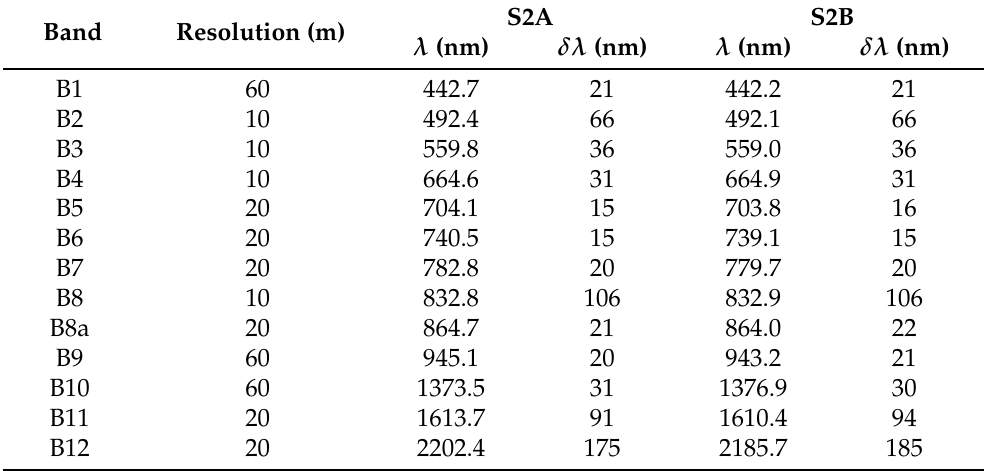
Table 1. Spatial resolution, central wavelength ( λ ), and bandwidth ( δλ ) of the two MSIs on board Sentinel-2